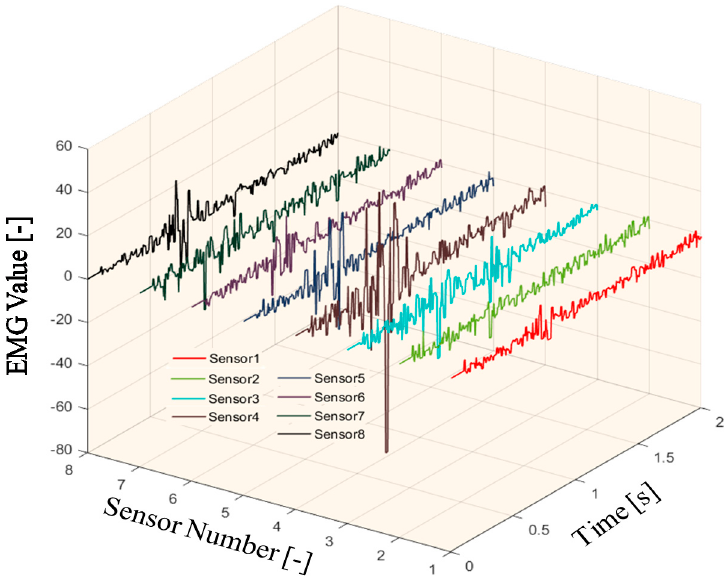
Figure 3. The electromyography (EMG) data in eight channels.